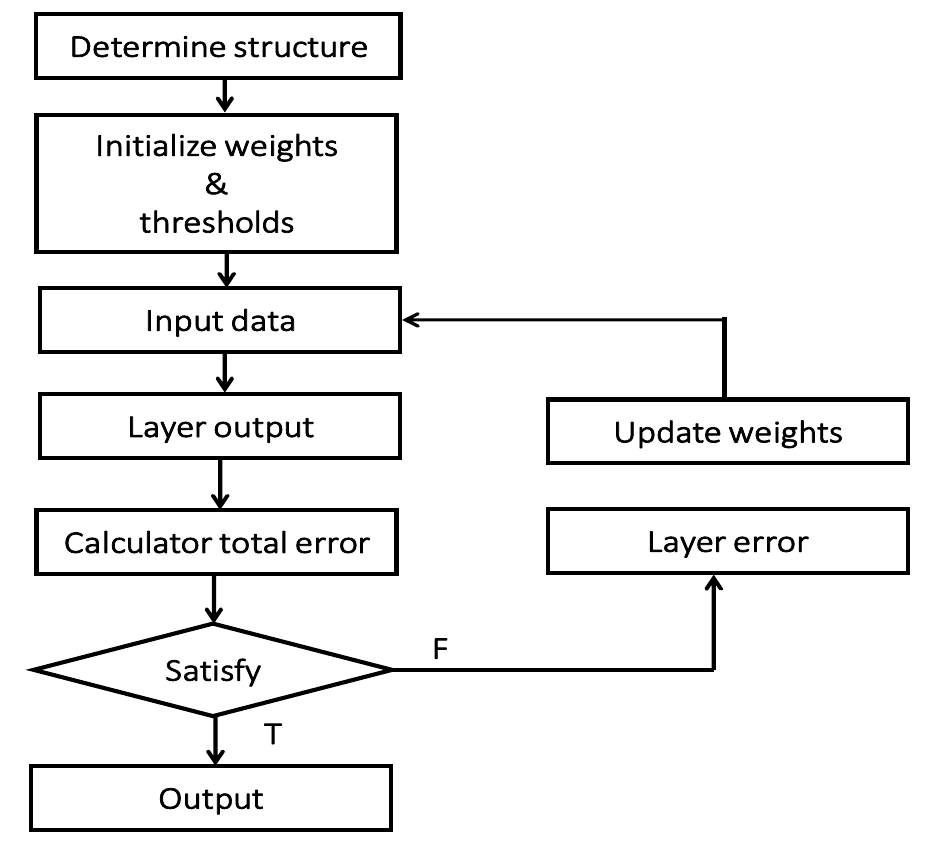
Figure 8. Flow chart of the neural network [56].